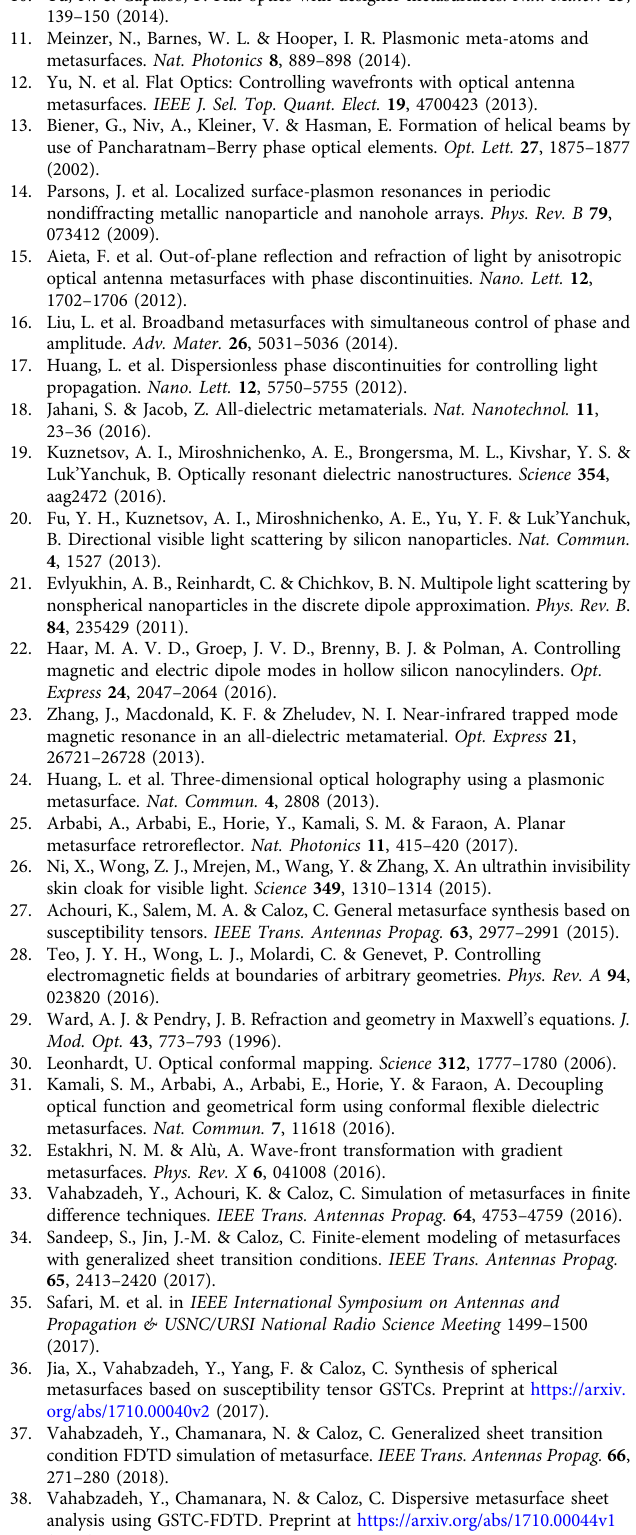
Supplementary Fig. 3. The magnetic fi eld distribution in Fig.